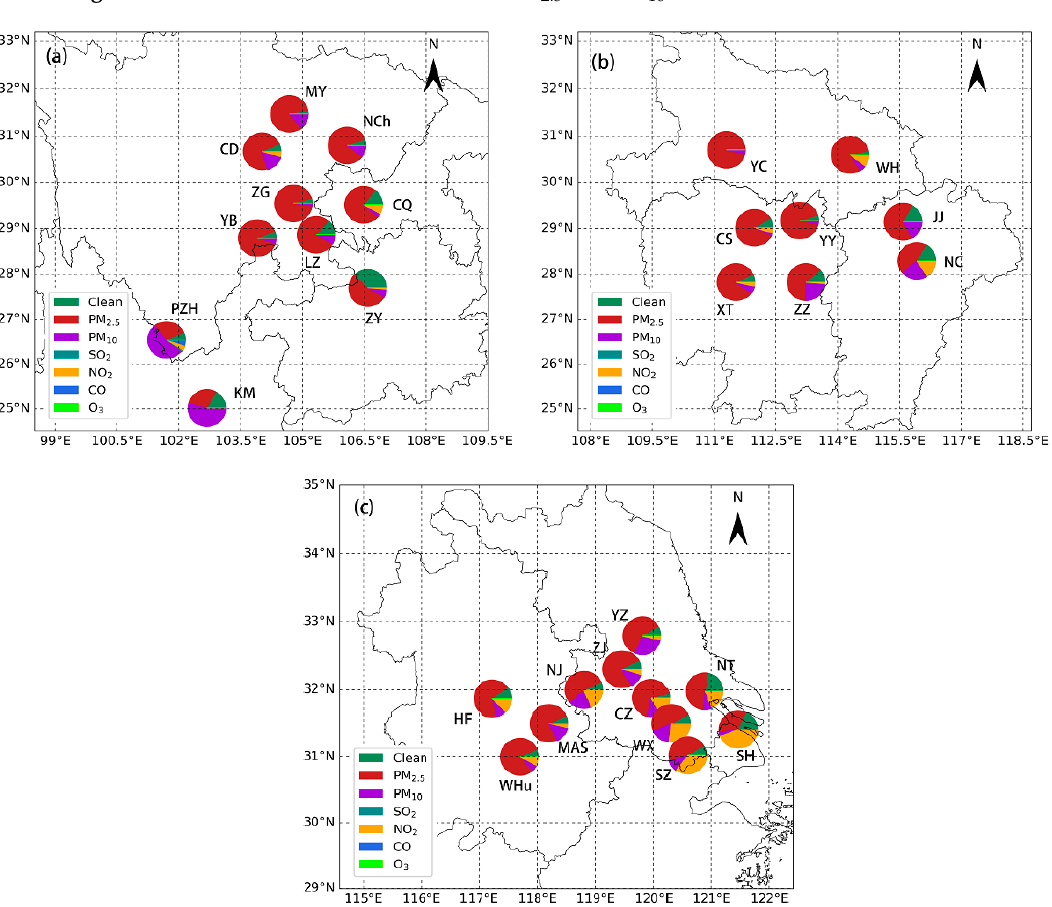
2.5 and PM 10 between cities over the YREB.